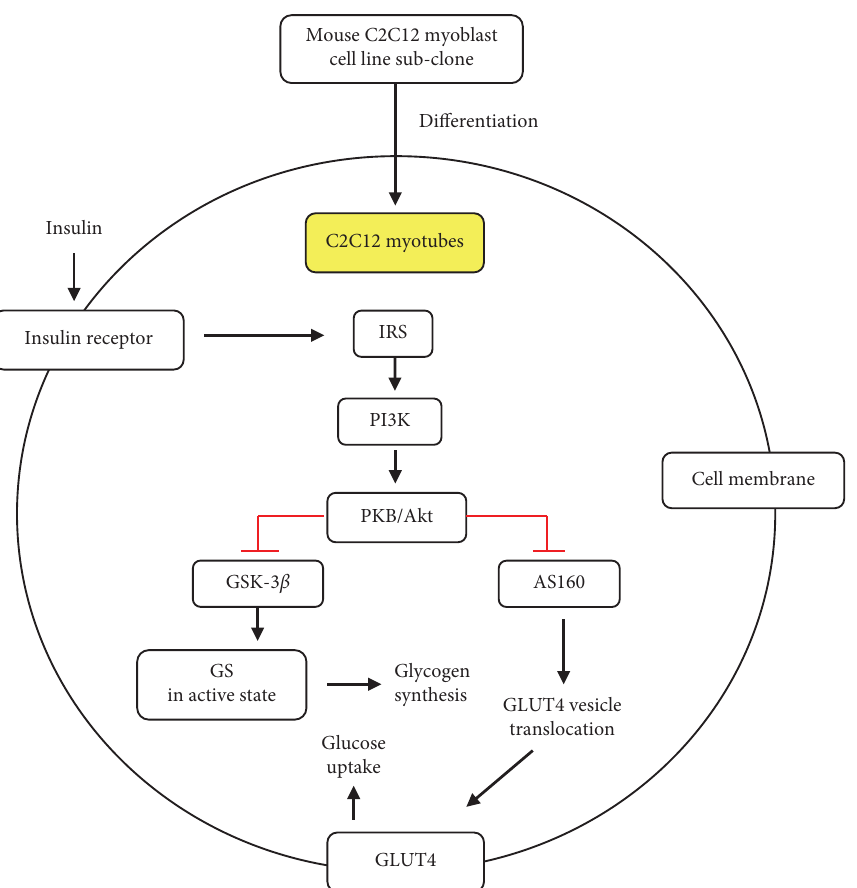
Figure 2: Te insulin signaling pathway in skeletal muscles (C2C12 cell lines). Te PI3K/Akt activation in skeletal muscle is triggered by insulin binding to its receptor. Activated Akt will promote glucose uptake as well as glycogen synthesis through the inhibition of GSK-3 β and AS160,